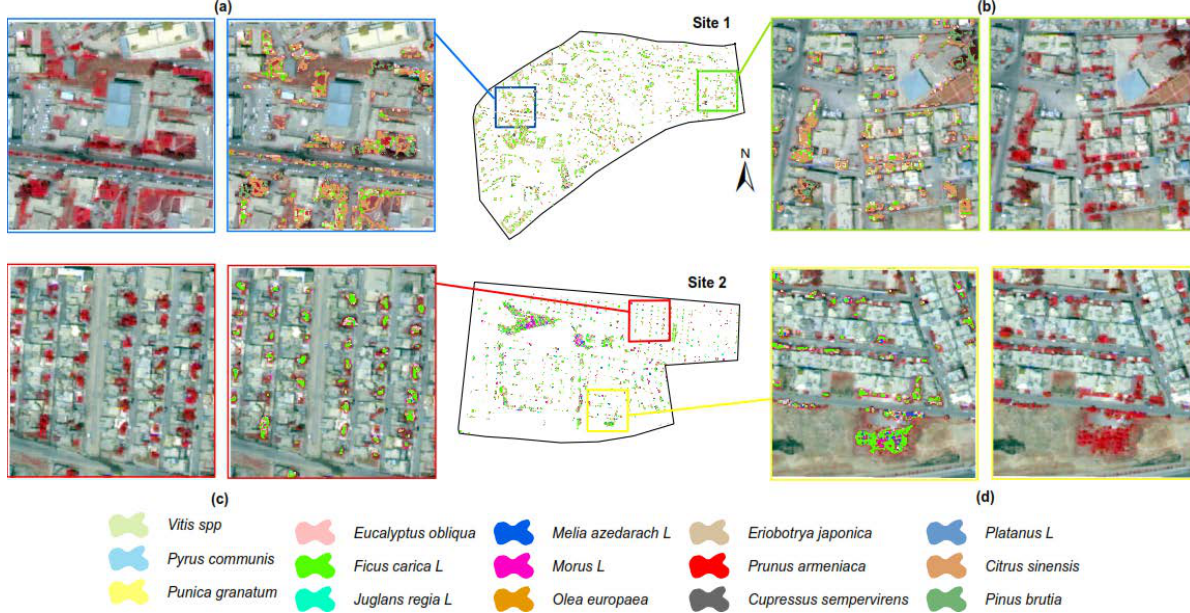
Figure 7: Classification map of all tree species in the study sites. (a) Sample 1 (SP01), (b) Sample 2 (SP02), (c) Sample 3 (SP03), (d) Sample 4 (SP04).